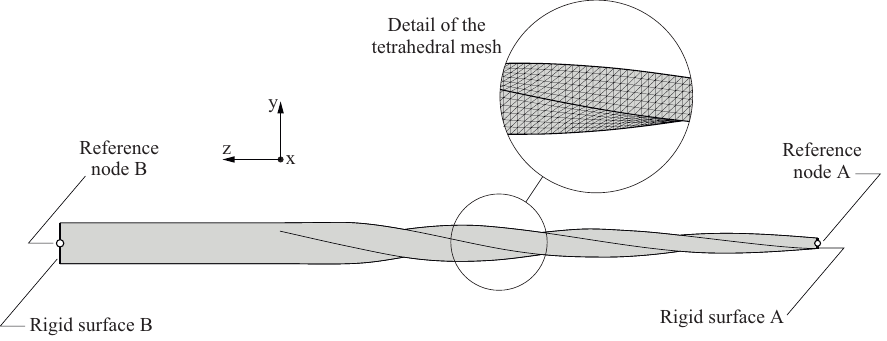
Figure 4. Definition of the finite element